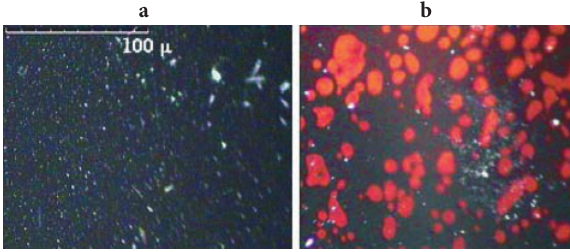
Fig. 6. The stereo microscope image for: a – control specimens with micron bar; b – 3.5 ‰ polypropylene modified specimens